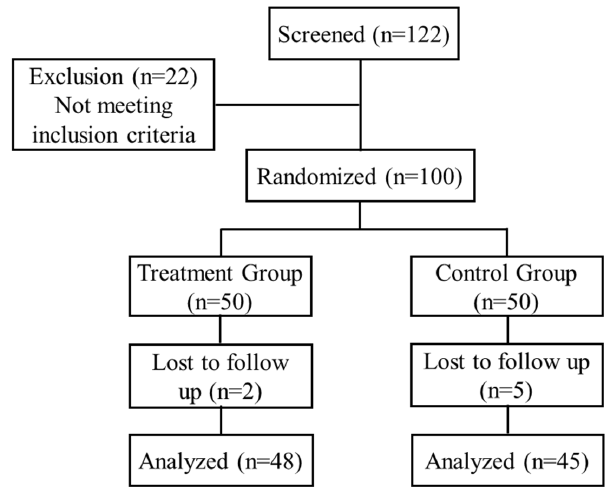
Figure 1. Consolidated standards of reporting trials (CONSORT) flow diagram of patients recruitment and analysis.